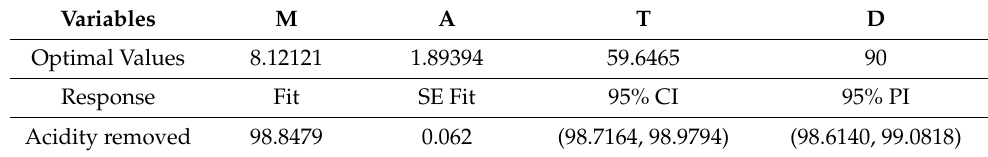
Figure 23. A regression fit between the experimental data and predicted data for acidity removal. Table 9. Optimal response analysis for the esterification of WCO using the RSM analysis